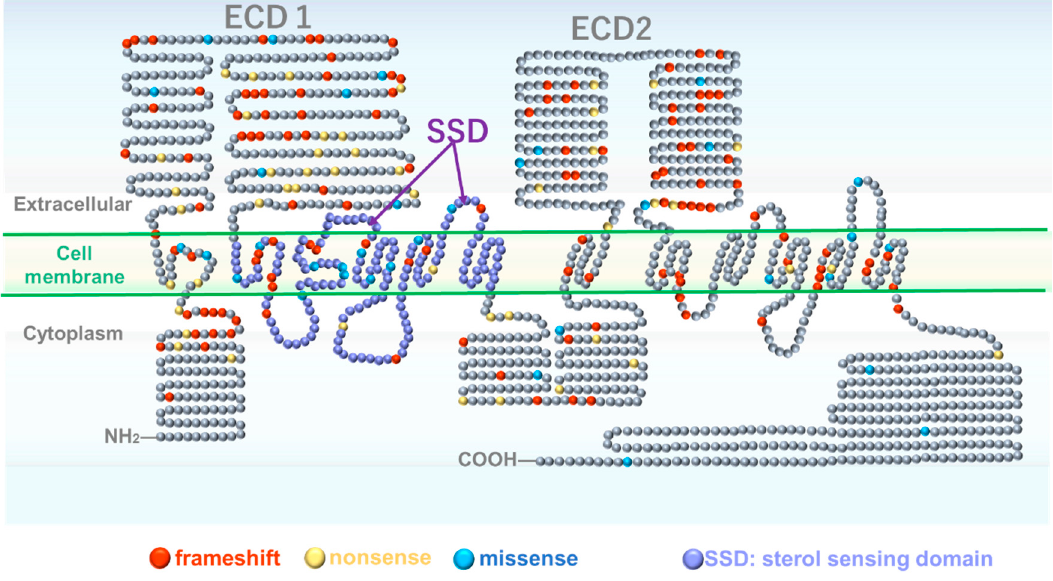
Figure 2. Patched 1 (PTCH1) gene mutation site and domain structure of Patched 1 protein. Each color dots showed the mutations in listed Table S1. ECD1: extracellular domain 1, ECD2: extracellular domain 2, SSD: sterol sensing domain. Each dot represents one amino acid that consist PTCH1. Gray dots indicate amino acids for which no mutations have been reported.